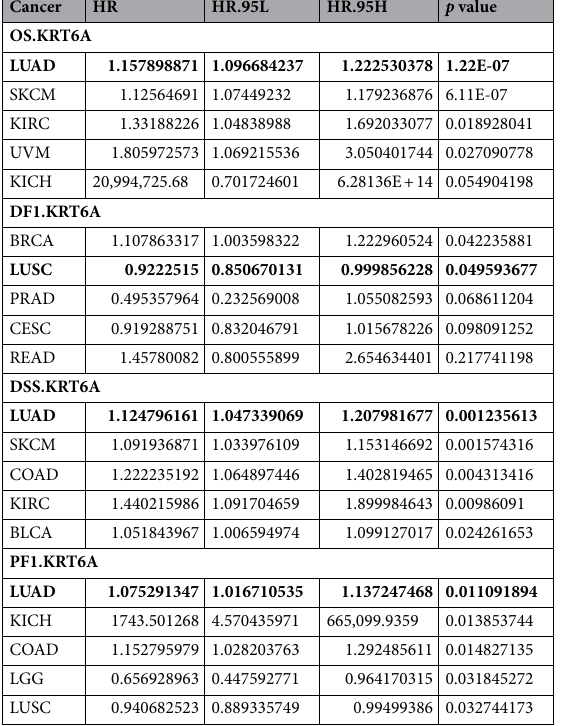
Table 1. Prognostic analysis of KRT6A.